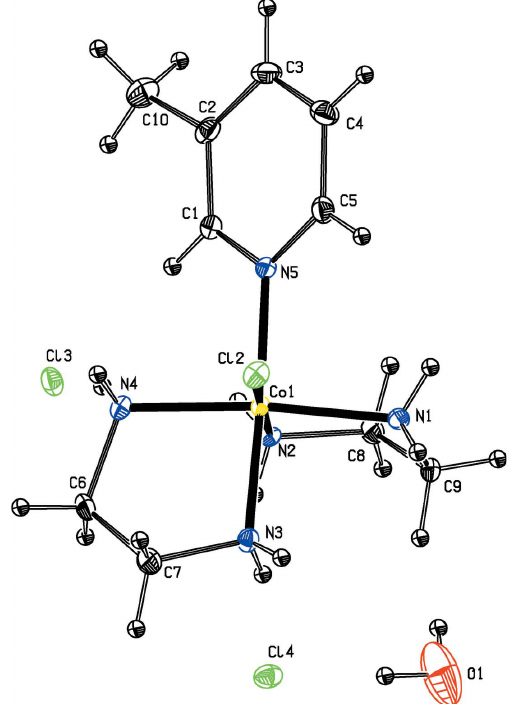
Figure 1 The molecular entities in the title structure with displacement ellipsoids at the 30% probability